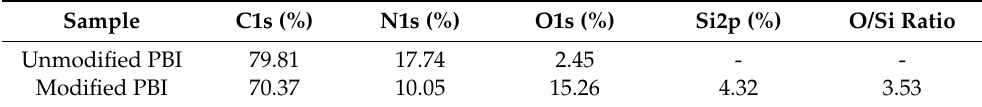
Figure 3. XPS spectra of the surfaces of both unmodified and modified membranes. Table 1. Elemental compositions of PBI membranes measured from the XPS analysis.